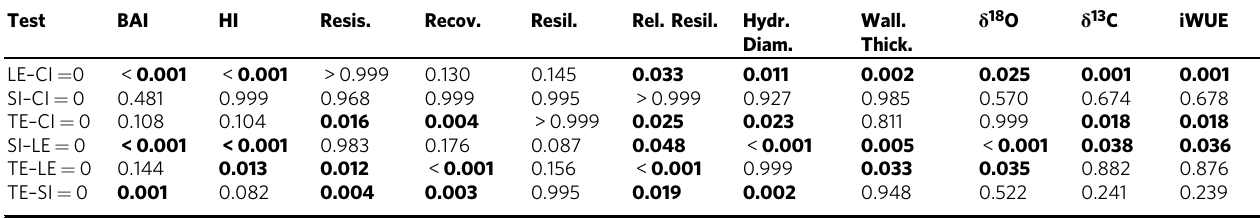
Multiplecomparisonsamongtreepopulationsrepresentingthefullnorth-southrangeofinteriorlodgepolepine( Pinuscontorta ssp. latifolia ).Populationsarerepresentedby fi veprovenancesgroupedinto four climatic regions, LE, CI, SI and TE: LE stands for the Leading Edge, i.e. the northern population occupying the area expected to be the leading edge of tree species migrations under climate warming; CIisCentralInteriorpopulation,locatedinthecentralareasofthelodgepolepinerange;SIistheSouthernInteriorpopulationcoveringthesouthernrangeofthecentralareasofthelodgepolepinerange; TE stands for the Trailing Edge, which represents seed sources from the far south of the lodgepole pine range, which is expected to see increased forest maladaptation under climate warming BAI is basal areaincrement, HI is heightincrement, Resis. is drought resistance, Recov. is drought recovery, Resil. is drought resilience, Rel. Resil. is drought relative resilience, Hydr. Diam. is mean hydraulic diameter, Wall. Thick. is mean tracheid wall thickness, and iWUE is intrinsic water-use ef fi ciency derived from tree-ring δ 13 C. Signi fi cance ( α = 0.05) is indicated in bold and p -values were adjusted with the Benjamini & Hochberg false discovery rate method